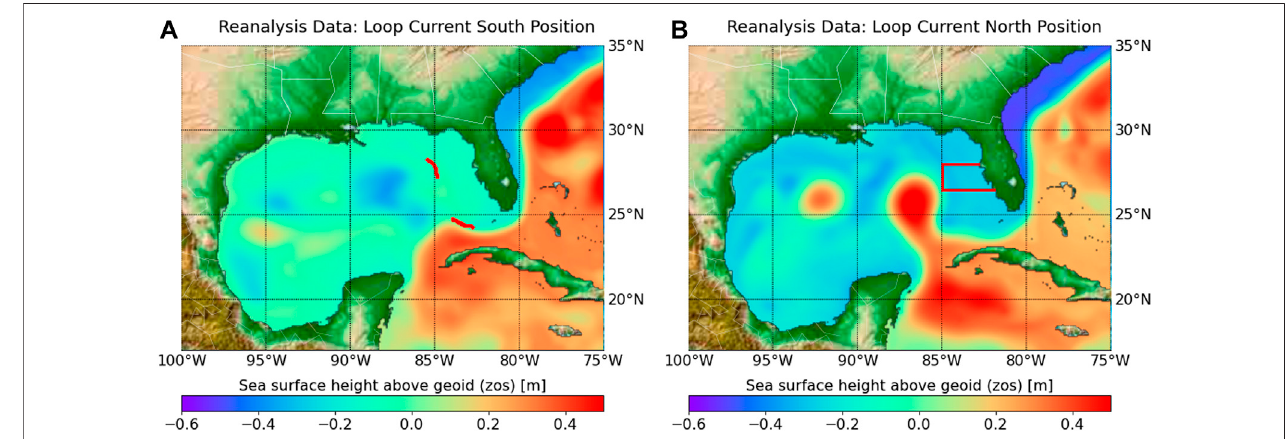
FIGURE1| Observationreanalysisdataofseasurfaceheightabovegeoid(zos)[m]showing (A) LC-Sand (B) LC-N.Tworedsegmentsalongthe300 misobathin (A) are used to determine Loop Current position. The area where red tide blooms are considered by Maze et al. (2015) and this study is shown in the red box of (B) .